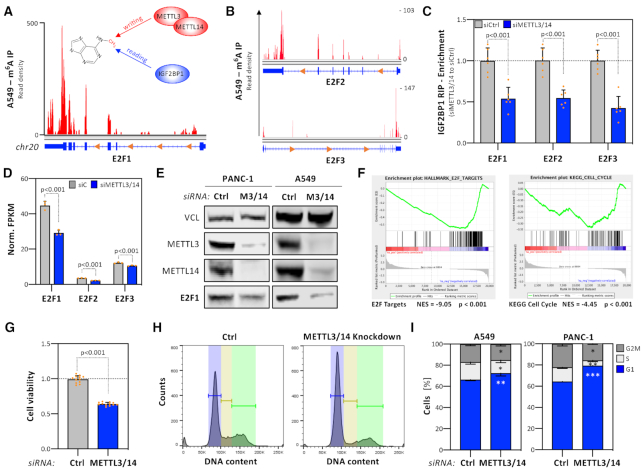
The E2F-dependent cell cycle progression controlled by IGF2BP1 is m6A-dependent. (A, B) N6-Methyladenosine RIP-seq profile of the E2F1 (A), E2F2 and E2F3 (B) mRNAs determined in A549 cells. Data were obtained from MeT-DB V2.0. The m6A-writing enzymes METTL3 and METTL14 as well as IGF2BP1 as an m6A-reader are indicated. (C) Co-purification of indicated mRNAs with IGF2BP1 in control- (gray, siCtrl) or METTL3/14-depleted (blue, siMETTL3/14) PANC-1 cells was analyzed by RIP using anti-IGF2BP1 antibodies and RT-q-PCR analysis. HIST1 served as normalization control. (D) Abundance of E2F1–3 mRNAs determined by RNA-seq upon transfection of indicated siRNAs in PANC-1 cells as shown in (C). (E) Representative Western blot analysis of indicated proteins upon control- and METTL3/14 depletion in PANC-1 (left) and A549 (right) cells. VCL served as loading control. (F) Gene set enrichment analysis (GSEA) of protein-coding genes upon METTL3/14 co-depletion in PANC-1 cells. Protein-coding genes were ranked by their fold change of mRNA abundance determined by RNA-seq as shown in (D). Results for the Hallmark pathway ‘E2F Targets’ (left) and the KEGG pathway ‘Cell Cycle’ (right) are shown. NES, normalized enrichment score. (G) PANC-1 cells were transfected with indicated siRNAs (grey, siCtrl; siMETTL3/14, blue). The viability of PANC-1 spheroids was determined 6 days post-transfection by CellTiter GLO, as described in Figure 2A. (H, I) Cell cycle progression analyses of control- or METTL4/14-depleted PANC-1 and A549 cells (I), as described in Figure 2B, C. Representative cell cycle phase distribution in PANC-1 cells is shown in (H). Statistical significance was determined by Mann–Whitney test: *P < 0.05; **P < 0.01; ***P < 0.001.